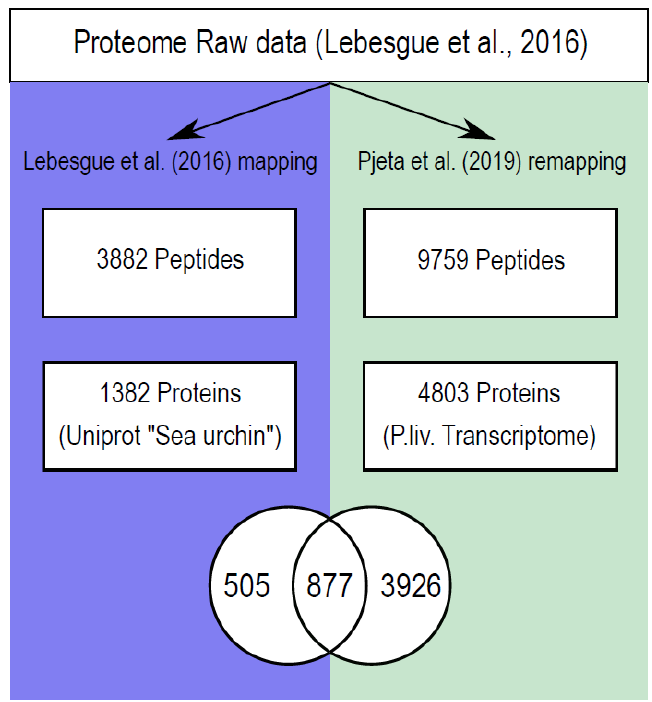
Figure 7. Comparison of the differential proteome re-analysis with the initial dataset of Lebesgue et al. Mass spectrometry peptide mapping to the transcriptome resulted in a drastic increase of successfully mapped peptides and proteins compared to the mapping of the previous study, in which the peptides were mapped against UniProt database hits for sea urchins. Both protein mappings had an overlap of 877 proteins, 505 are uniquely found in the Lebesgue data, whereas 3926 proteins are newly identified in the present study.